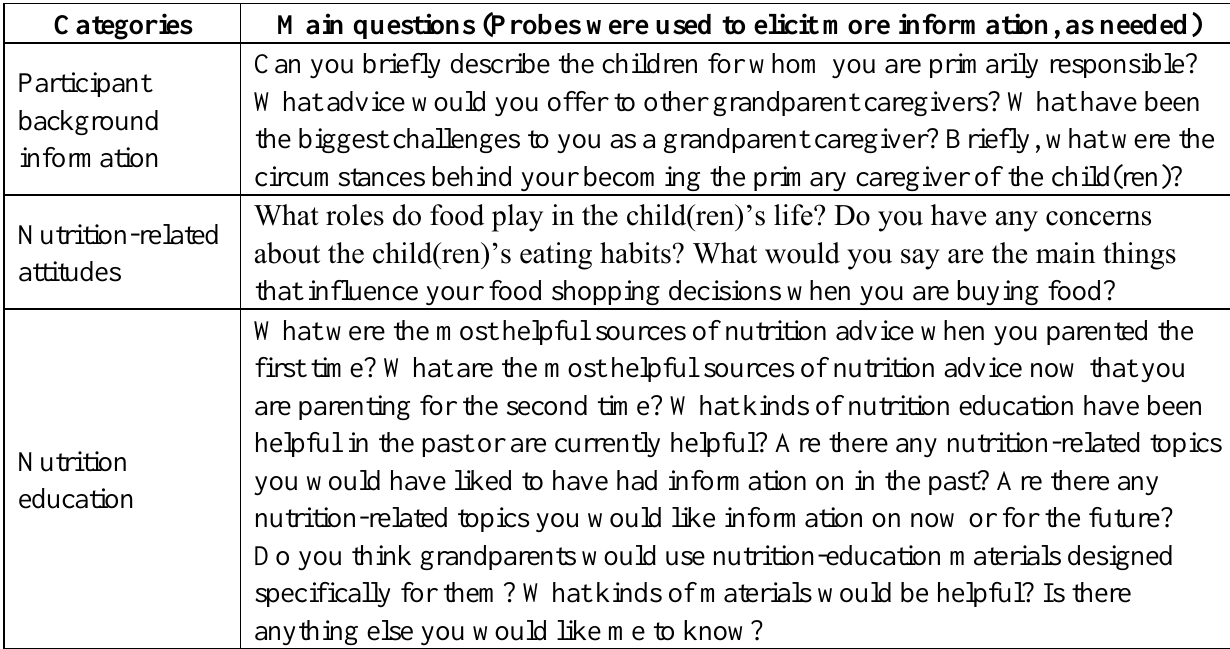
Table 1. Main questions of the interview